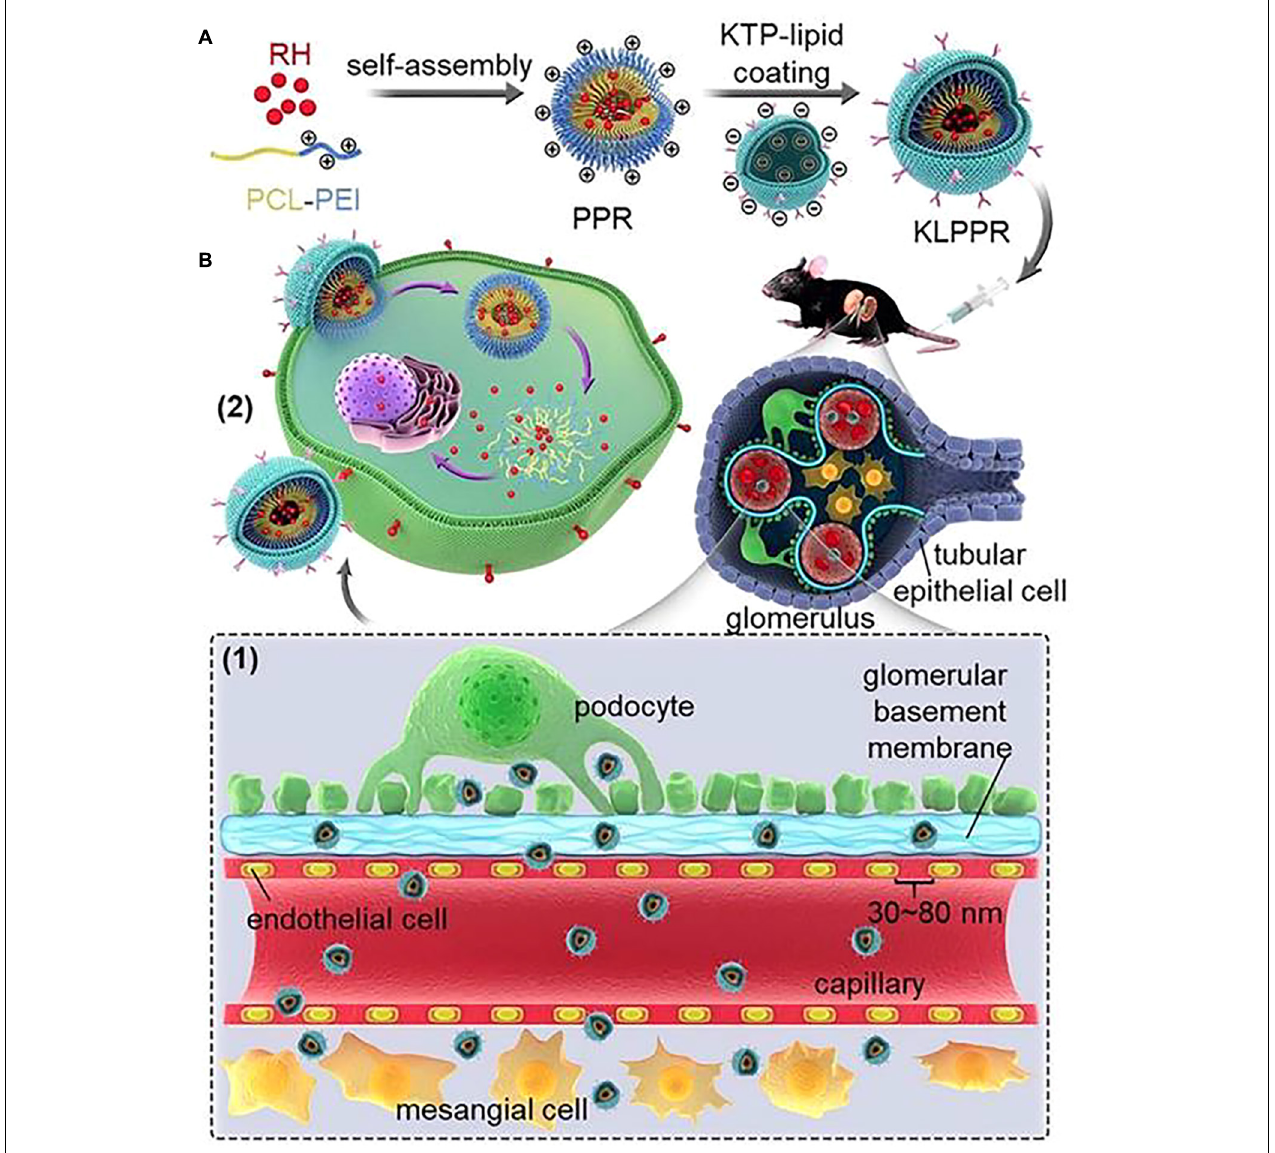
FIGURE 7 | KLPPR liponanoparticles for kidney-targeted drug delivery. (A) Kidney-targeted rhein (RH)-loaded liponanoparticles (KLPPR) with polyethyleneimine (PCL-PEI)-based cores and KTP-modified lipid layers. (B) Size control (30–80 nm) enables the particle to pass through the filtration membrane, and KTP decoration promotes cellular uptake and kidney retention of the particle. Reproduced with permission (Kvirkvelia et al., 2018).